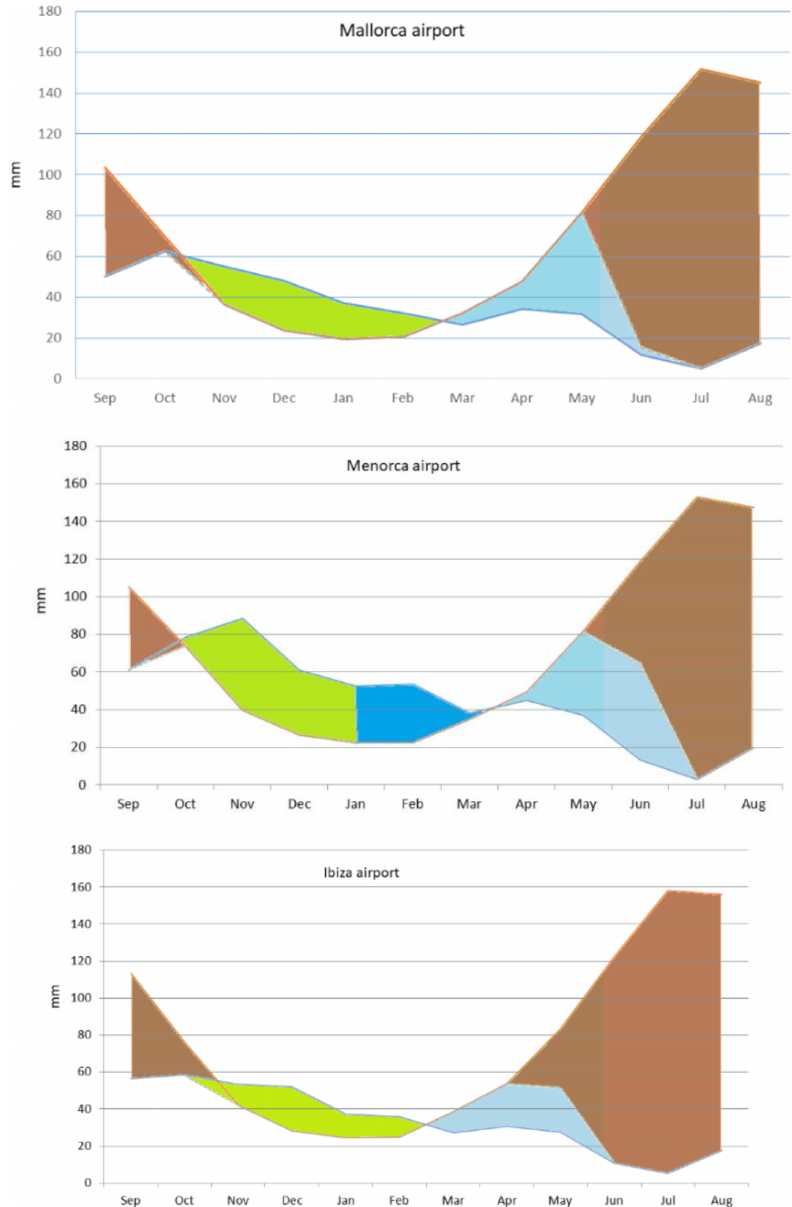
Figure 6. Climatic water balance (1981–2010) at the airports of Mallorca, Menorca and Ibiza (MaA, MeA and IbA in Fig. 1). Lines: blue is precipitation (mm); brown is potential evapotranspiration (mm); dashed green is evaporation (mm). Colored areas: green is the accumulation of water in the soil; cyan is the evaporation of water stored in the soil; blue is runoff; brown is the water deficit in the